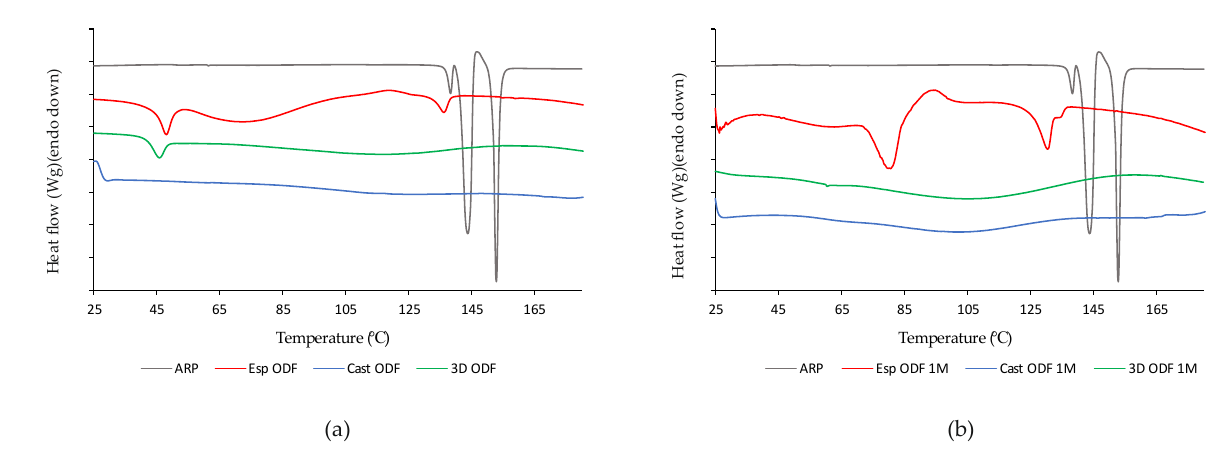
Figure 4. DSC heating curves ( a ) directly after ODFs preparation; ( b ) after one month of storage at 25 °C and 60% RH) of raw ARP (gray line) and ODFs prepared by electrospinning (red line), casting (green line) and 3D printing (blue line) method.